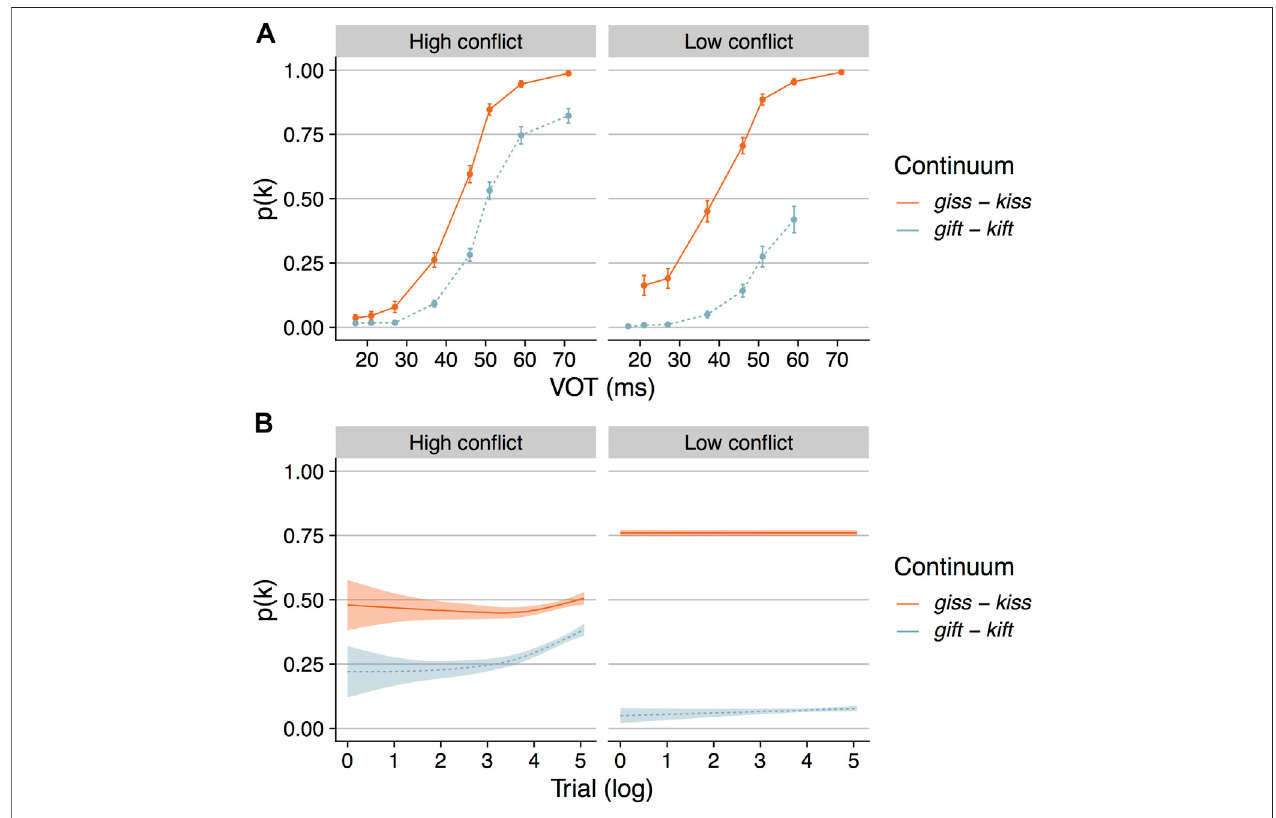
FIGURE3|(A) showsmeanproportion/k/responsesateachvoice-onset-time(VOT)foreachcontinuumseparatelyforthehighcon fl ictandlowcon fl ictconditions.Means re fl ect grand means calculated over by-subject averages. Error bars indicate standard error of the mean. Panel (B) shows smoothed conditional means (re fl ecting a generalized linear model fi t to trial-level raw data using thegeom_smooth () function in theggplot2 package in R) for proportion /k/ responses over time(i.e., log-transformed trialnumber) for each continuum separately for the high con fl ict and low con fl ict conditions. The shaded region indicates the 95% con fi dence interval.